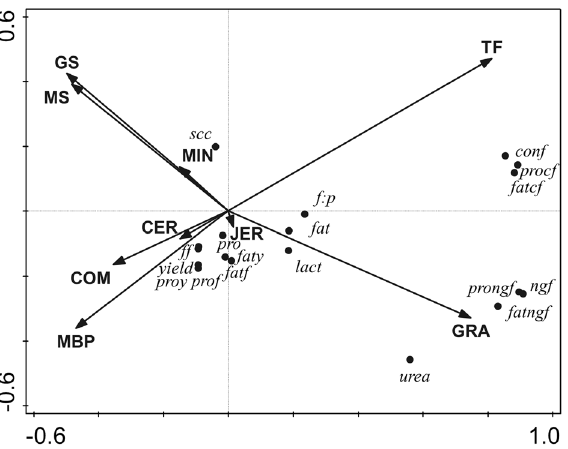
Figure 1. Biplot derived from the redundancy analysis, showing the relationship between diet composition parameters (total forage, TF; estimated grazing, GRA; grass silage, GS; maize silage, MS; hay/straw, HS; moist by-products, MBP; cereals, CER; minerals, MIN; compound feed, COM) and breed (Jersey, JER), relative to (i) milk yield (kg/cow/day), (yield), and basic composition parameters including milk fat yield (kg/cow/day), (faty) ; milk protein yield (kg/cow/day), (proy) ; milk fat content (g/kg milk), (fat) ; milk protein content (g/kg milk), (pro) ; fat:protein ratio, (f:p) ; milk lactose content (g/kg milk), (lact) ; milk urea content (g/kg milk), (urea) ; milk SCC (× 1000/ml milk), (scc) ; and (ii) efficiency parameters including feed efficiency (kg milk/kg DMI), (ff) ; feed non-grazing efficiency (kg milk/kg non-grazing DMI), (ngf) ; feed concentrate efficiency (kg milk/kg concentrate DMI), (conf) ; fat efficiency (g fat yield/kg DMI), (fatff) ; fat non-grazing efficiency (g fat yield/kg non-grazing DMI), (fatngf) ; fat concentrate efficiency (g fat yield/kg concentrate DMI), (fatcf) ; protein efficiency (g protein yield/kg DMI), (fatff) ; protein non-grazing efficiency (g protein yield/kg DMI), (prongf) ; protein concentrate efficiency (g protein yield/kg concentrate DMI), (procf). The total adjusted explained variation was 85.6%. Axis 1 explained 82.8% of the variation and Axis 2 explained a further 3.5% of the variation. Continuous variables, shown as arrows were the following (presented in order of contribution to the explained variation; P -value also shown in parentheses): TF (55.5%, P = 0.002), GRA (12.1%, P = 0.002), MS (5.5%, 0.002), COM (5%, P = 0.002), MBP (3.7%, P = 0.002), MIN (3.1%, P = 0.002), GS (1.2%, P = 0.001), JER (6.6%, P = 0.0.006), CER (< 0.1%, P =